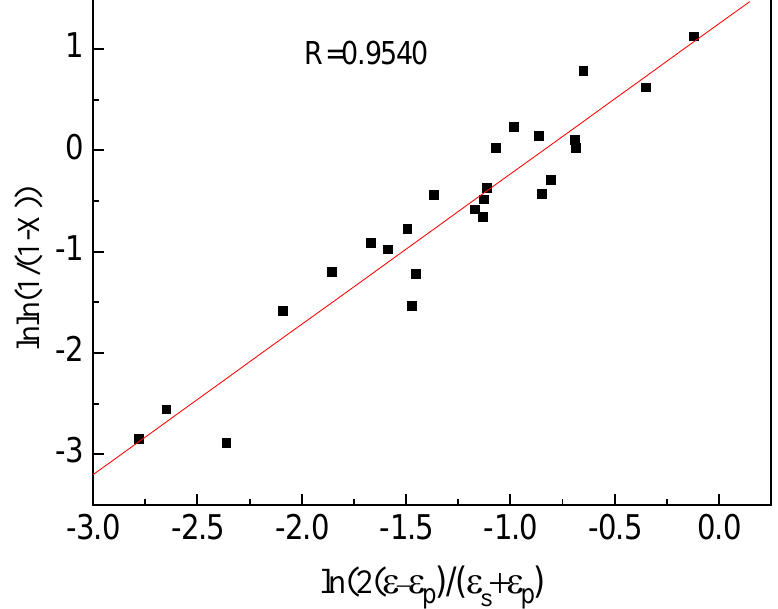
Figure 8. Relation between lnln(1/(1 − X )) and ln(2( ε − ε p )/( ε s + ε p )).